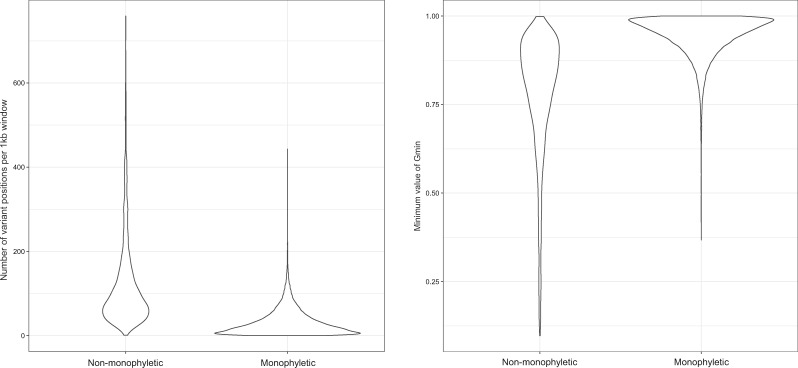
—Distribution of variable sites in monophyletic and nonmonophyletic 1 kb windows in the genome of Zymoseptoria tritici. Violin plots showing the number of variant sites for monophyletic and nonmonophyletic windows (left) and the distribution of minimum Gmin values obtained from a comparison of Z. tritici and each of the other Zymoseptoria species in monophyletic and nonmonophyletic windows (right).